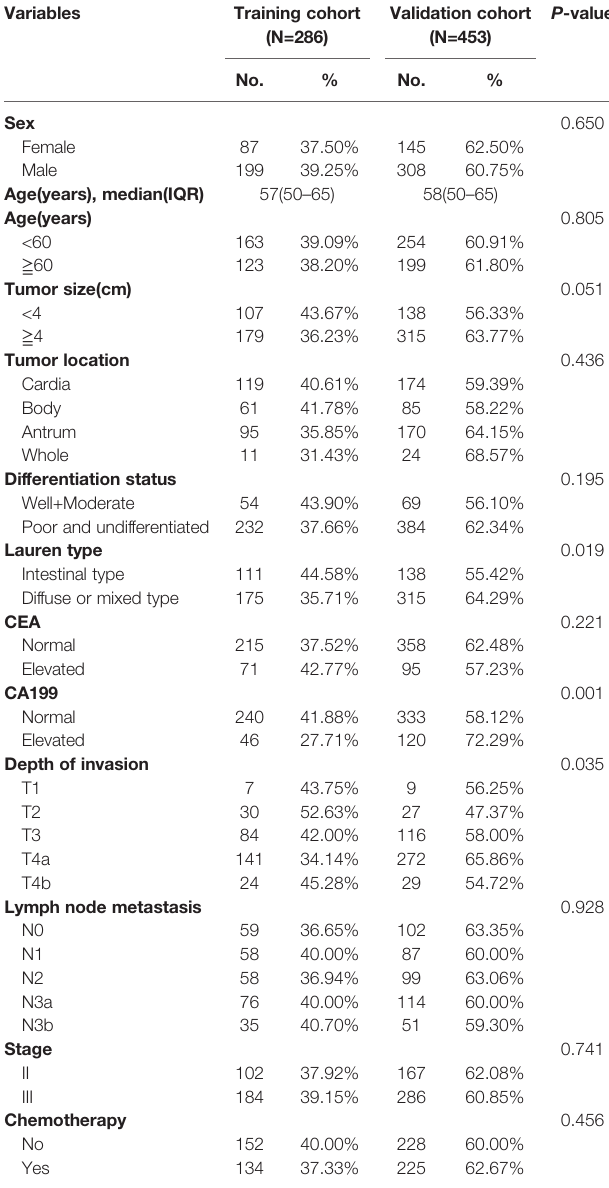
TABLE 1 | Clinical characteristics of the patients in the training and validation cohorts.